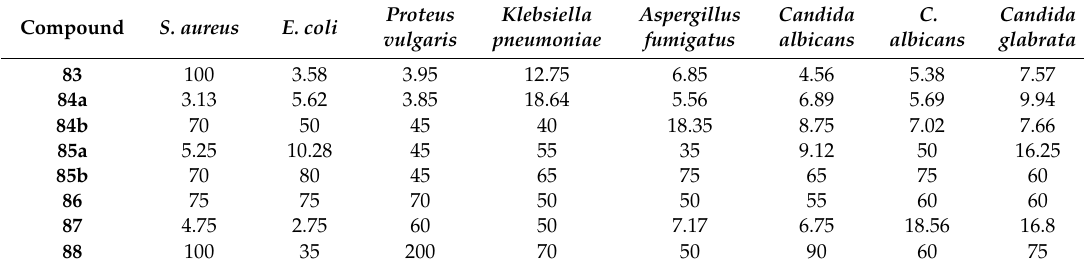
Table 21. Antimicrobial activity of 83 – 88 tested against Staphylococcus aureus 209 p, Escherichia coli ESS 2231, Proteus vulgaris , Klebsiella pneumoniae , Aspergillus fumigatus , Candida albicans , Candida krusei GO3, and Candida glabrata HO3 expressed as MIC values in µ g / mL.